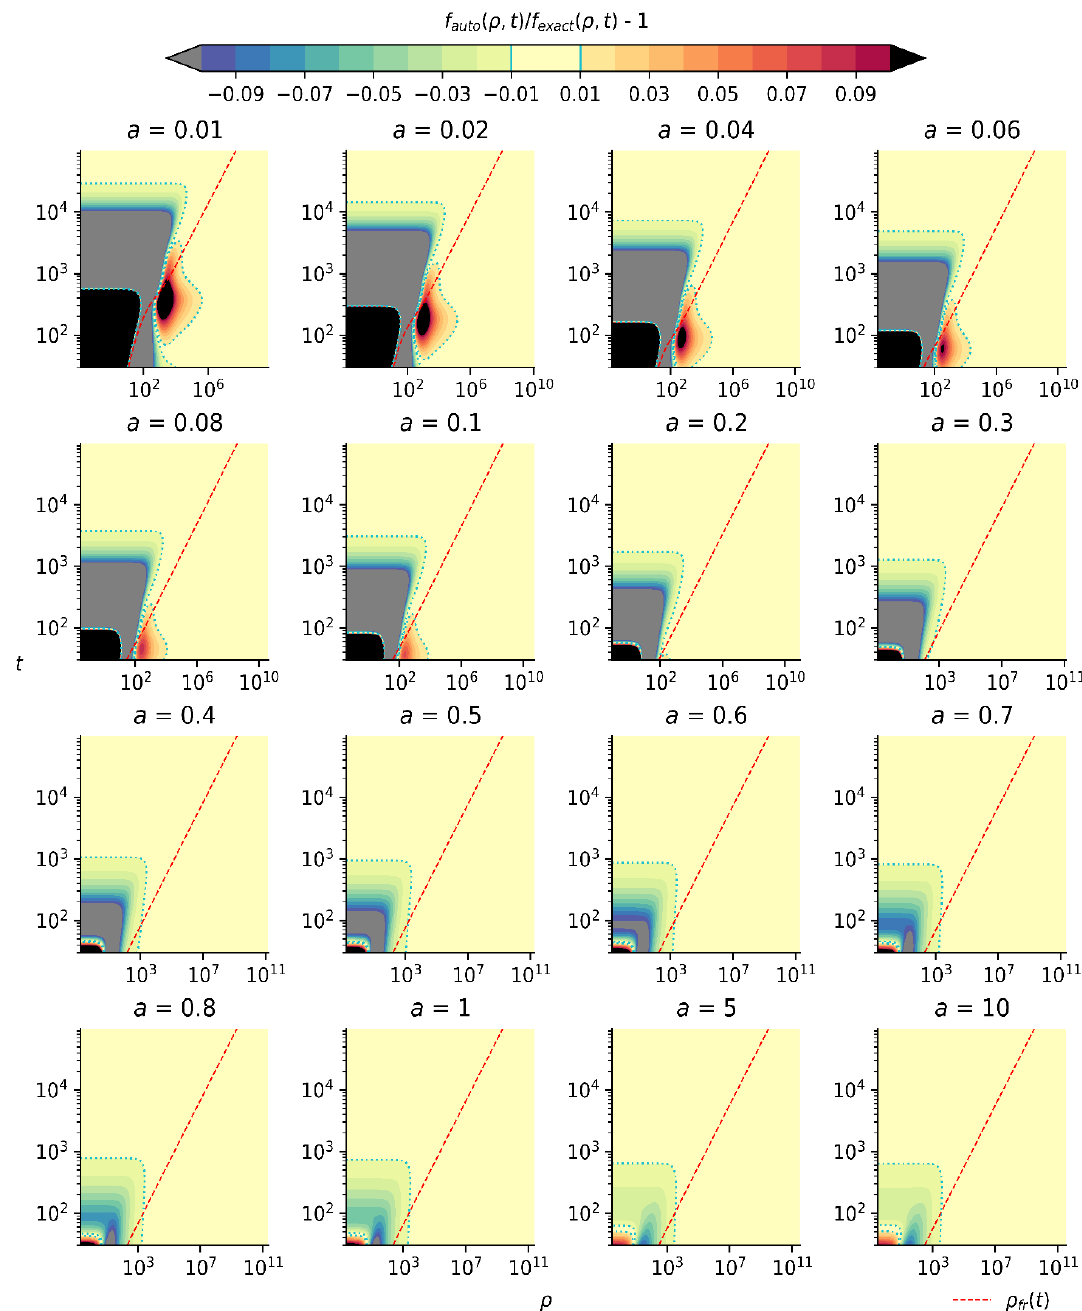
Figure 3. The level lines of the relative deviation of the automodel solution from the exact one, for the results from Figure 2.